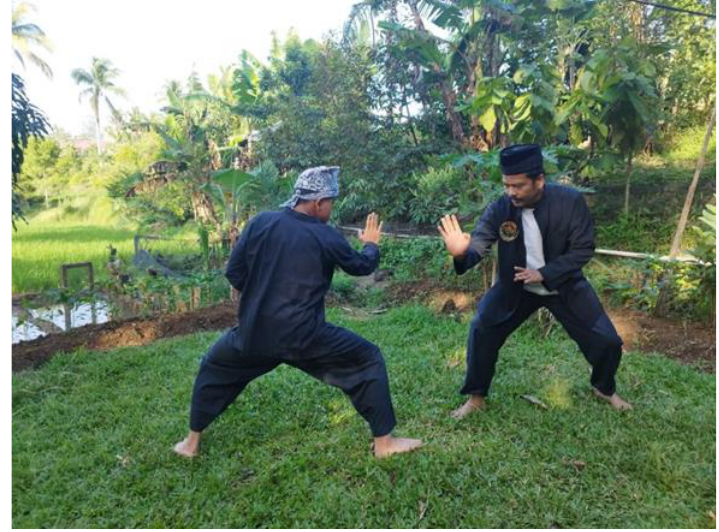
Fig. 2 Silek practice, (Abdullah,